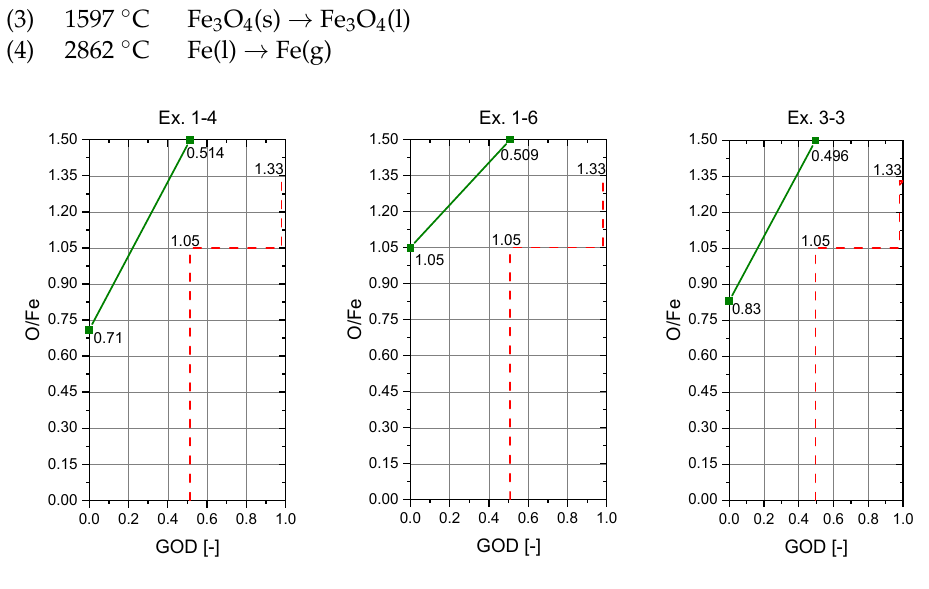
Figure 25. RIST diagrams for Ex. 1–4, Ex. 1–6, and Ex. 3–3.